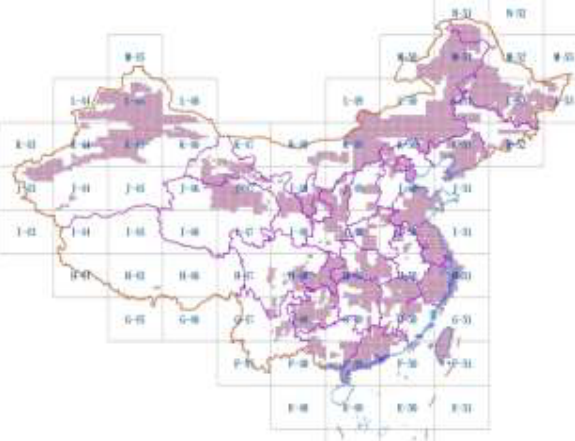
Figure 4. The coverage of collected digital orthophoto